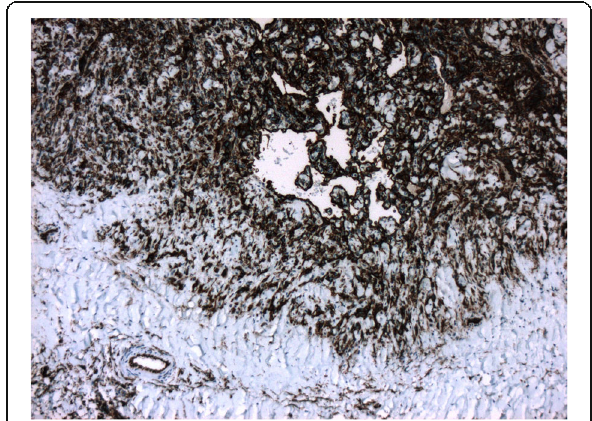
Fig. 3 Immunohistochemistry positive for